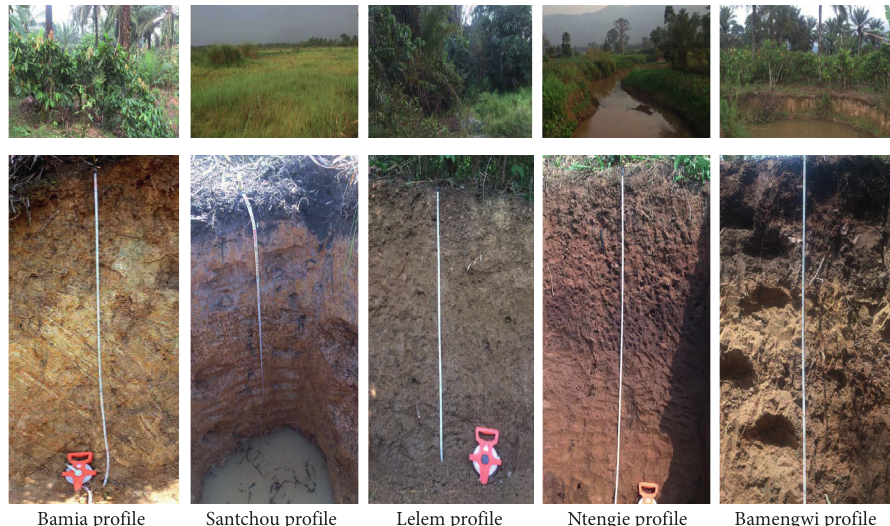
Figure 3: Landscapes and vegetation of different sampling sites and their corresponding soil